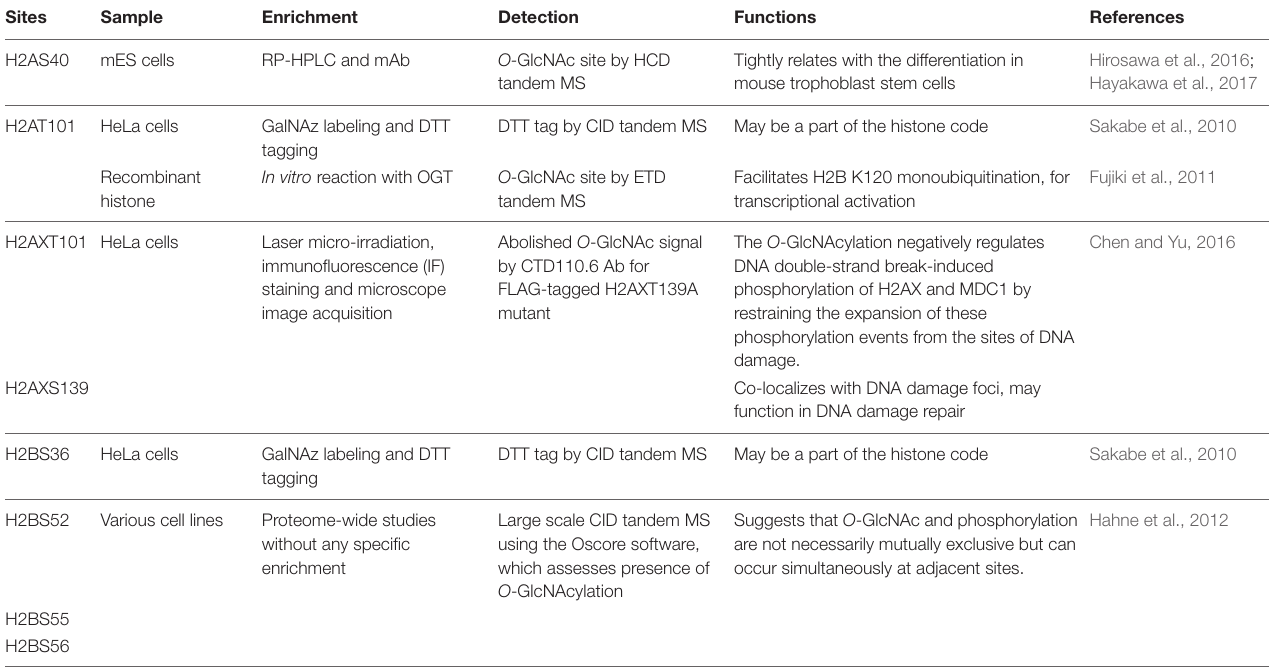
TABLE 1 | Reported sites of direct O -GlcNAc modification of